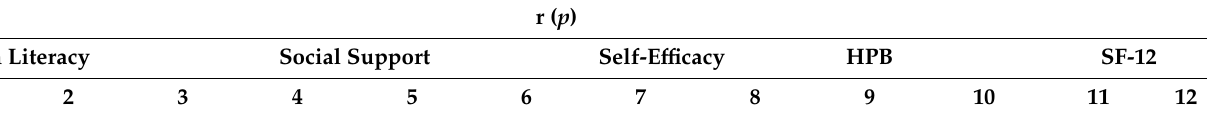
Table 3. Correlations among variables ( N =